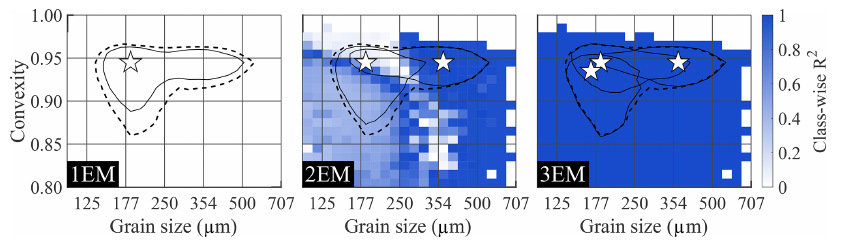
Figure 3. Class-wise R 2 distributions for endmember modelling results of the ConD2d 3EM_nonoise dataset from a 1EM up to a 3EM solution. Solid black lines denote endmember contours: lines drawn along those size–shape classes where the volume of the endmember SSD equals 0.5%. The median SSD of the dataset (average SSD) is represented by a dashed line at 0.2% volume. White stars denote the modes of the endmember size–shape distributions.